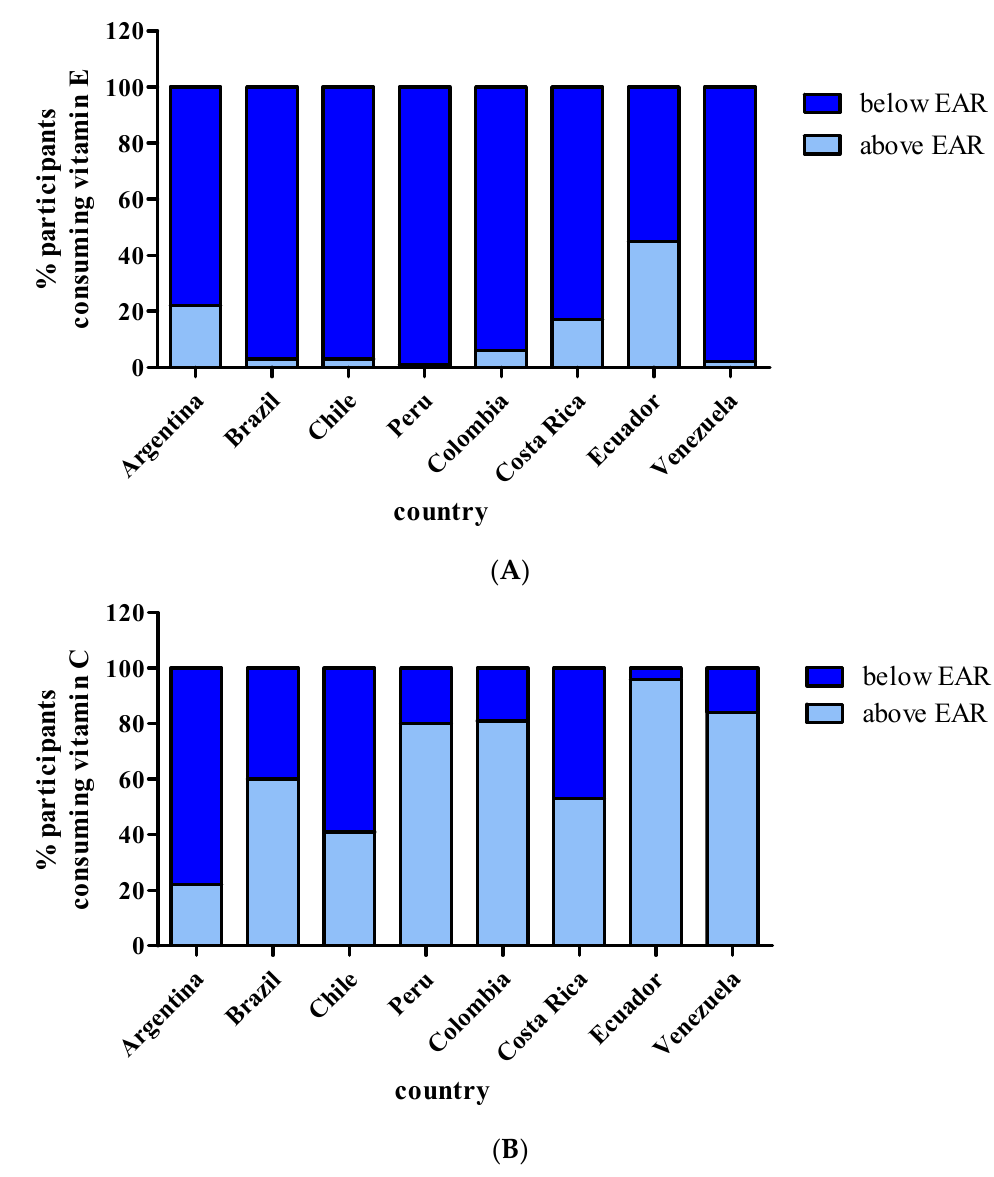
Figure 1. Prevalence of adequacy (% of population above EAR) and inadequacy (% of population below EAR) for vitamins E ( A ) and C ( B ) in LatAm WRA participating in ELANS.